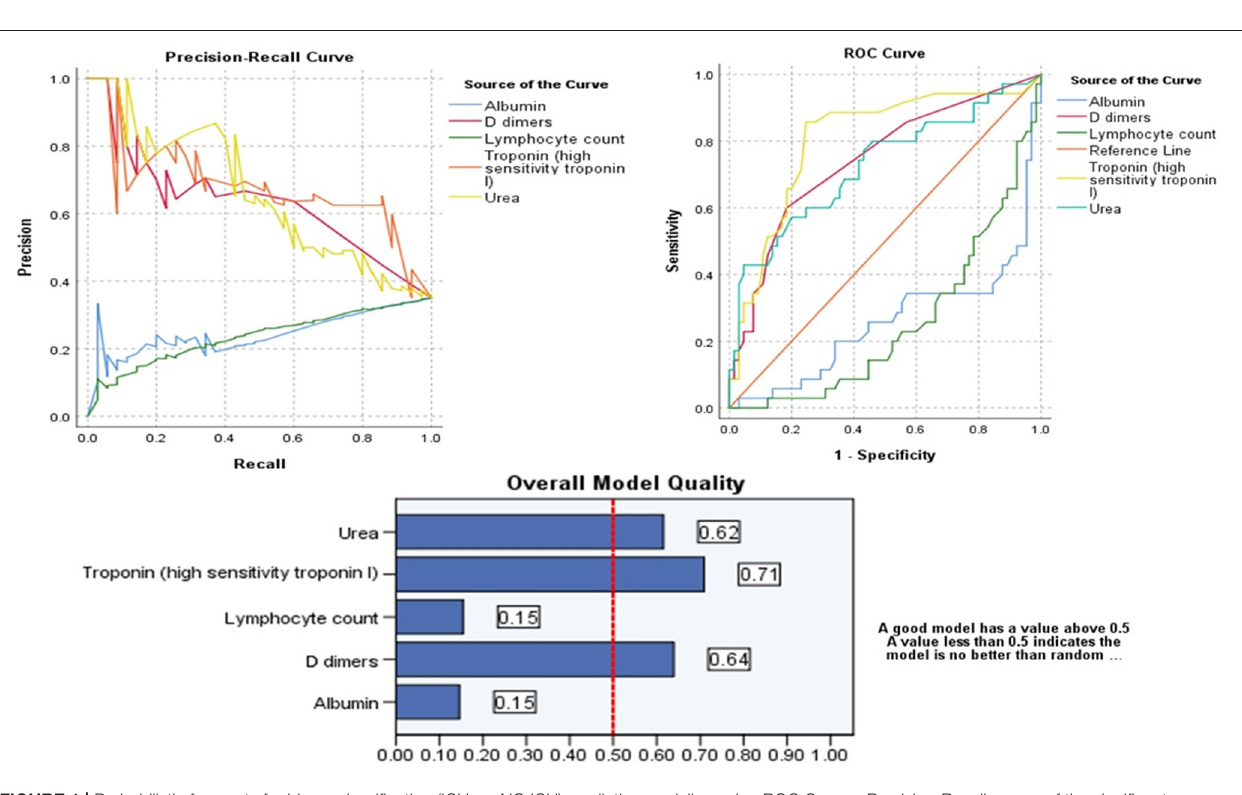
FIGURE 1 | Probabilistic forecasts for binary classification (ICU vs. NO ICU) predictive modeling using ROC Curves, Precision-Recall curves of the significant parameters and Overall Model Quality.